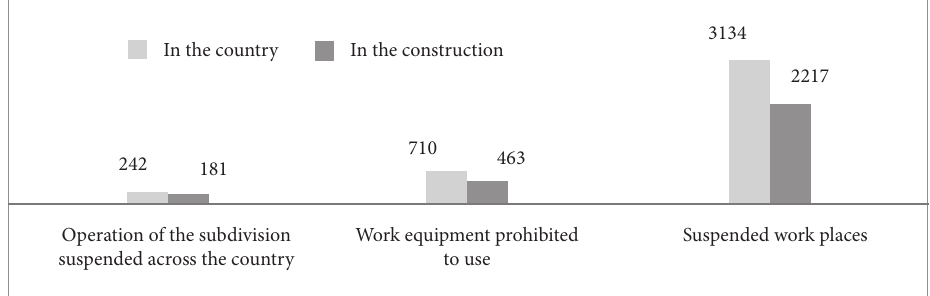
Operation of the subdivision suspended across the